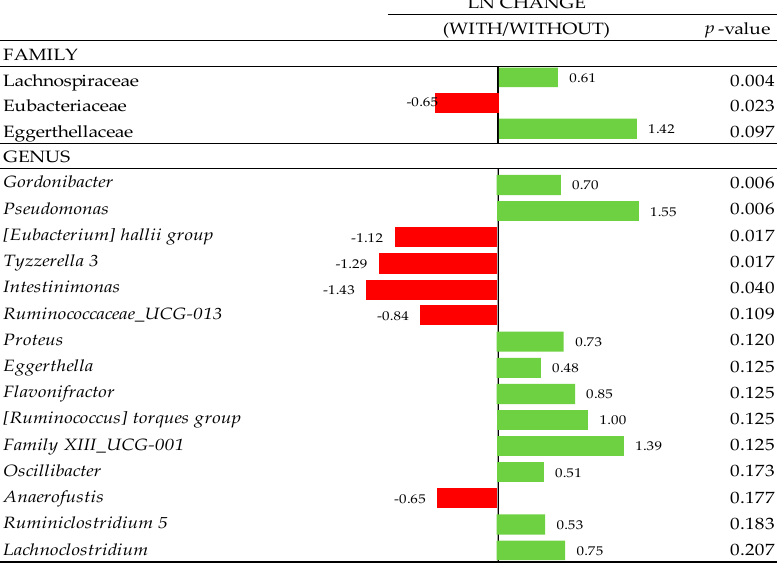
Figure 7. Ln changes promoted by xylanase inclusion (fold discovery rate p- adjusted < 0.20) in taxa. Positive values (  ) and negative values (  ) indicate greater and lower abundance. Taxa are sorted by level of significance (from higher to lower). Differences presented are based on all taxa detected in samples per